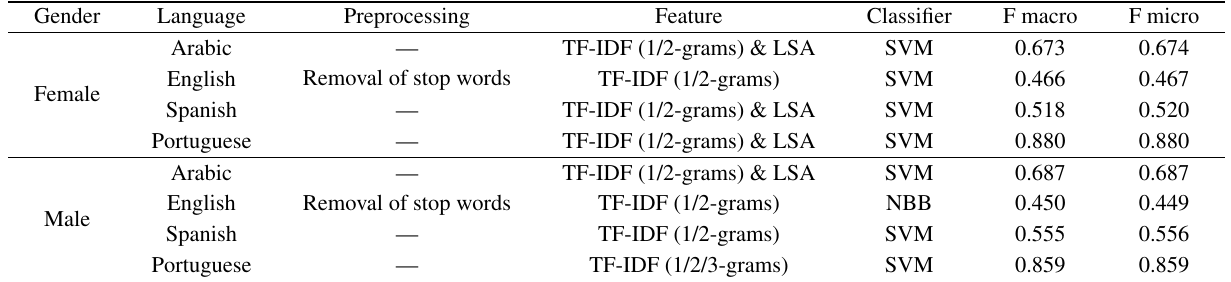
Table 11 Successive classification [48] .